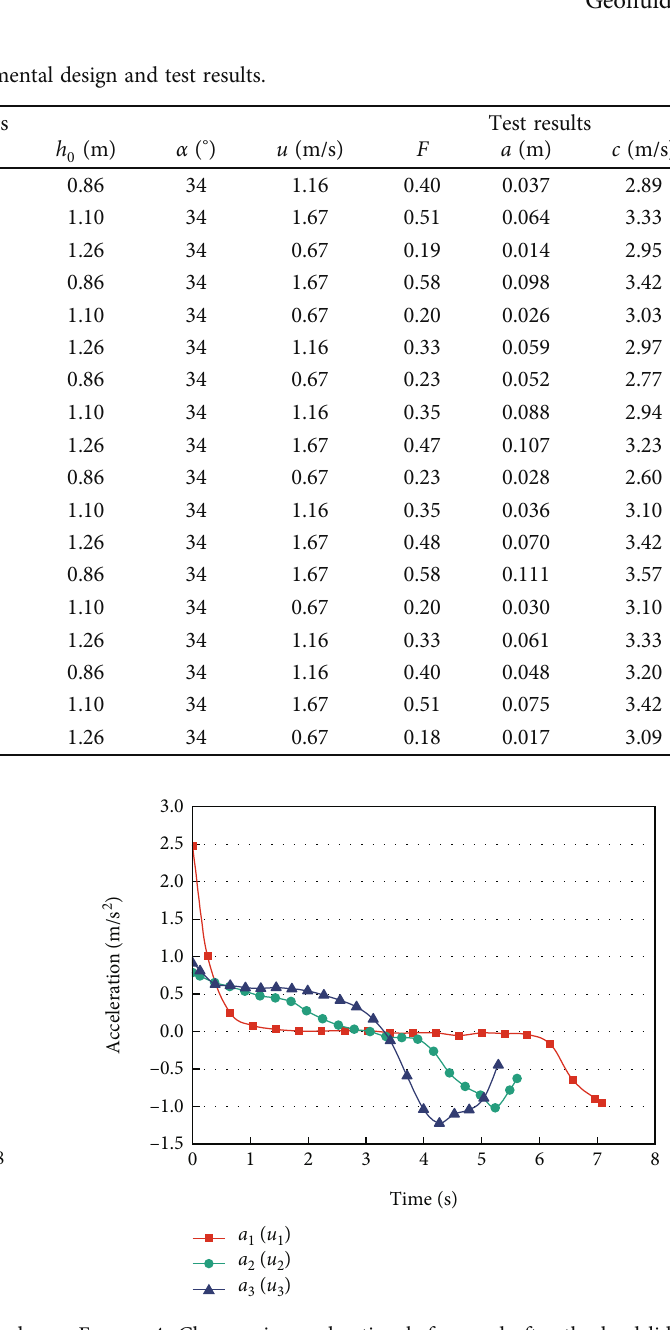
Figure 4: Changes in acceleration before and after the landslide body entered the water at three sliding